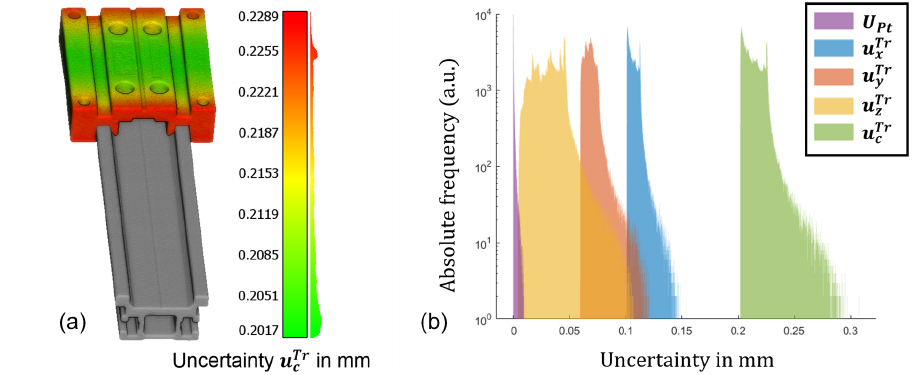
Figure 5. Uncertainty u Tr c of the slider (a) and histogram of uncertainty components U Pt , u Tr x , u Tr y , u Tr z , and u Tr c (b) .